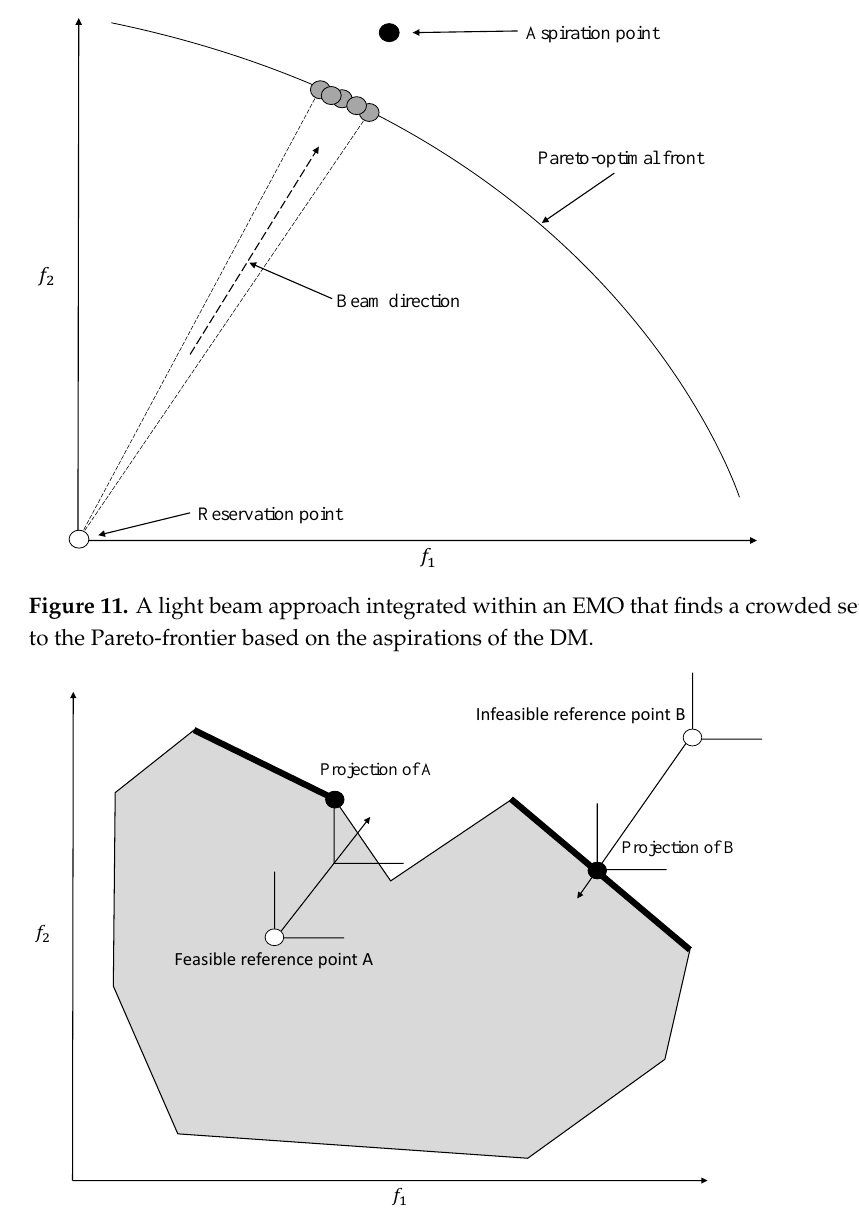
Figure 12. Projection of a feasible and infeasible reference point on the Pareto-optimal frontier within an